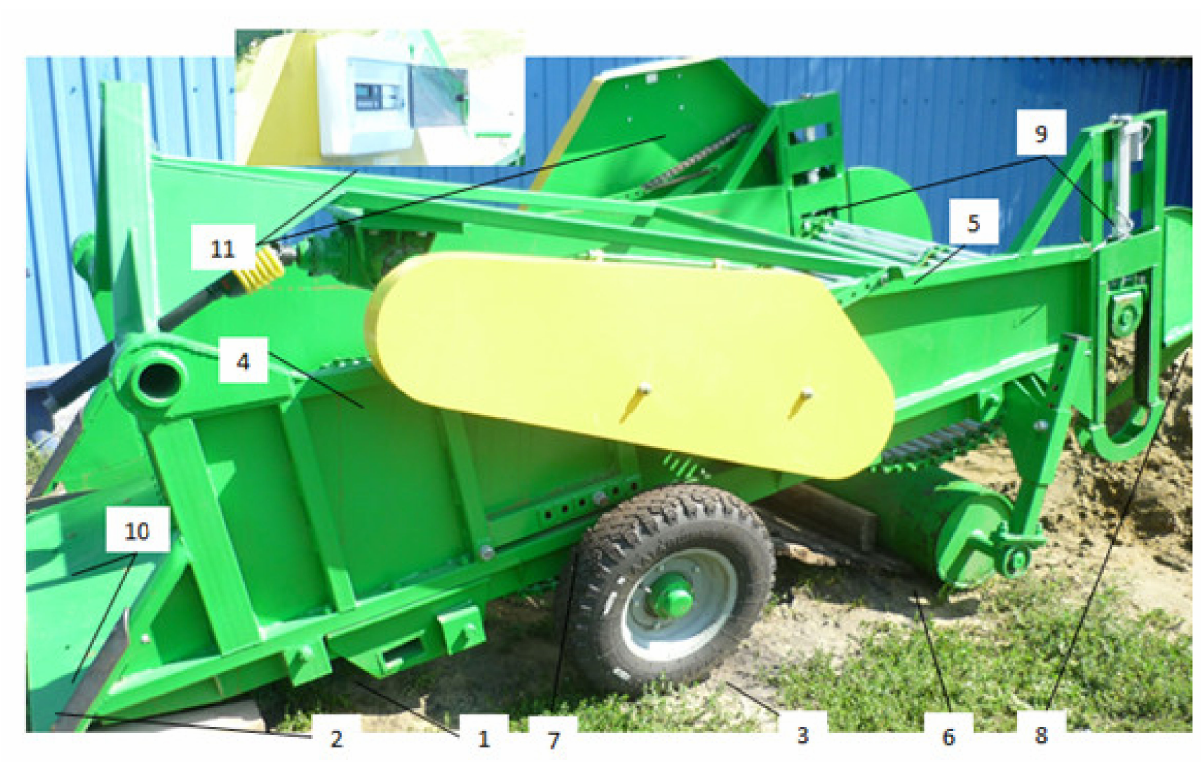
Figure 16. General view of a machine for harvesting root crops and onions, equipped with a separating rod elevator with an adjustable angle of inclination of the web: 1, frame; 2, digging ploughshare; 3, support wheels; 4, main separating rod elevator; 5, additional rod elevator; 6, roller- bed-forming machine; 7, adjusting plate of the shaker; 8, narrowing tray; 9, electric cylinders; 10, weight sensor of the digging ploughshare; 11,